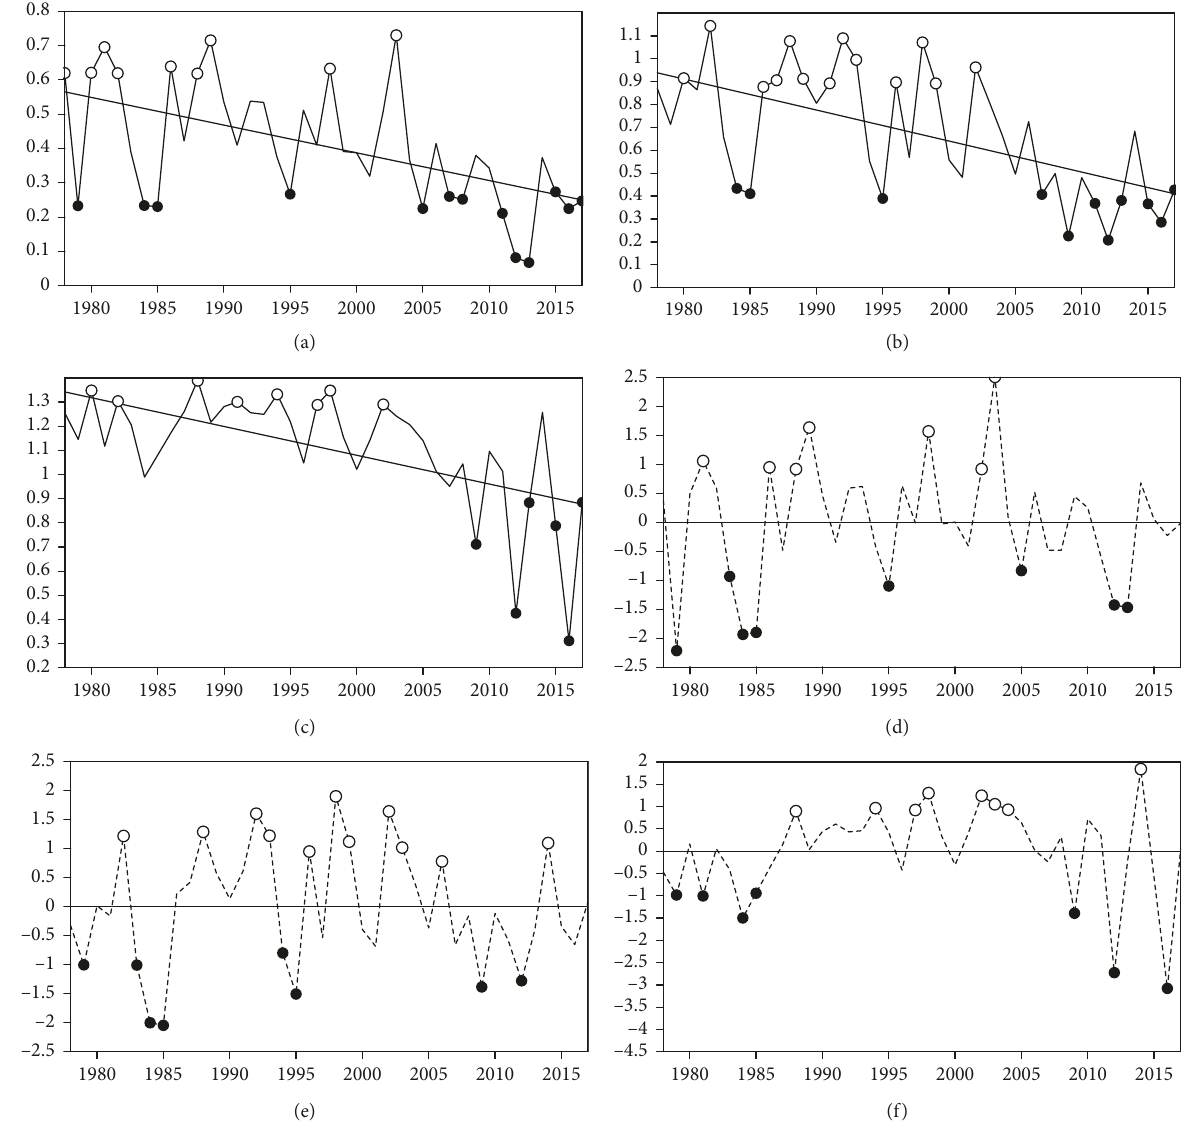
Figure 2: BKI time series for September (a, d), October (b, e), and November (c, f) showing the time series of both the OBKI in the left panels (unit:10 5 km 2 ) and the DBKI in the right panels. The straight lines in the left panels denote the linear trends in the OBKI. Those years with high BKI values ( > 0.75 SD) and low BKI values ( < − 0.75 SD) are marked by circles and black dots,